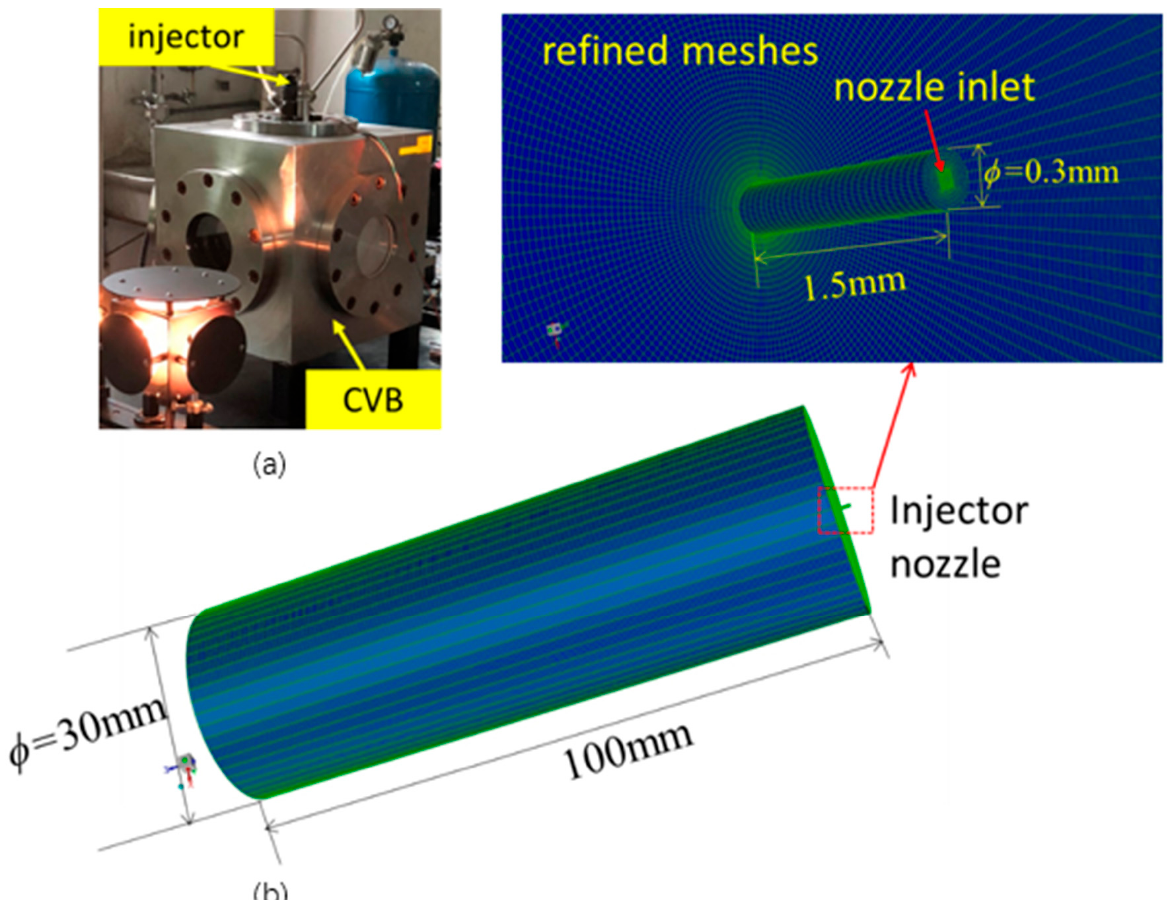
Figure 3. Model of diesel spray in the CVP. ( a ) constant volume pump (CVP); ( b ) A 3D model mesh based on the diesel injection prototype CVP system.